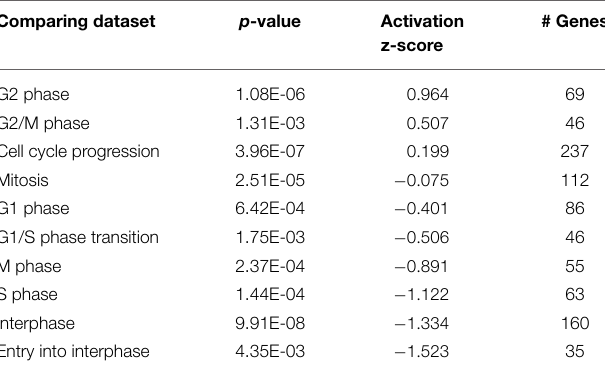
TABLE 2 | Comparison of the hair cell dataset with known expression changes in datasets from different stages of cell cycle. Comparing dataset